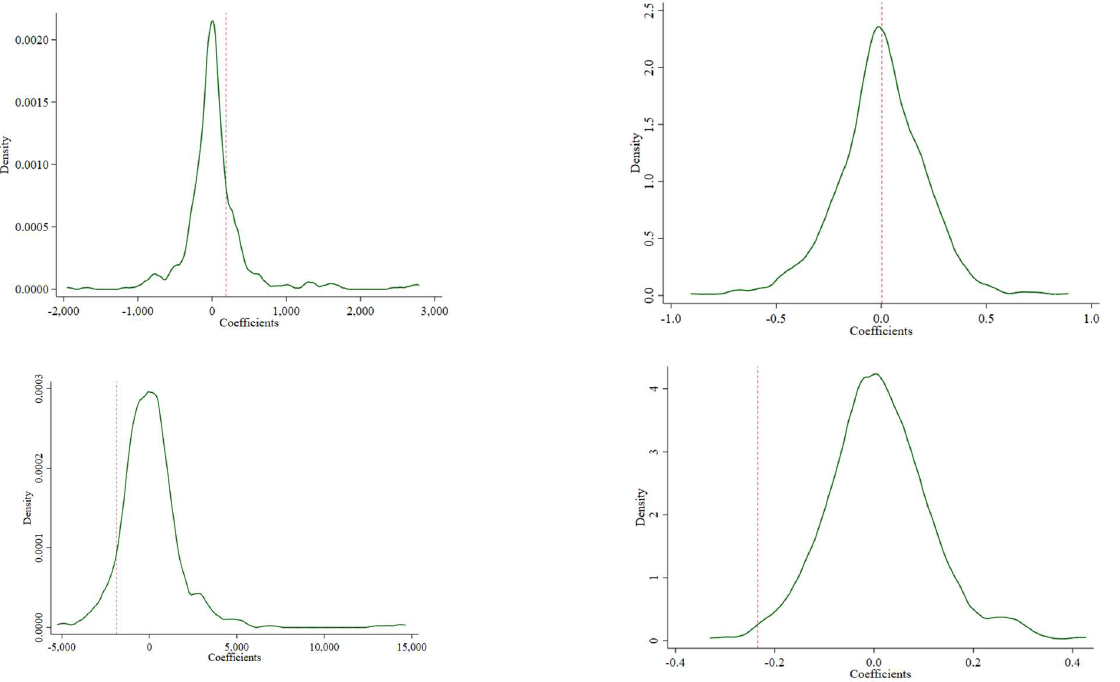
Figure 2. Kernel density diagram of interaction term coefficient distribution.